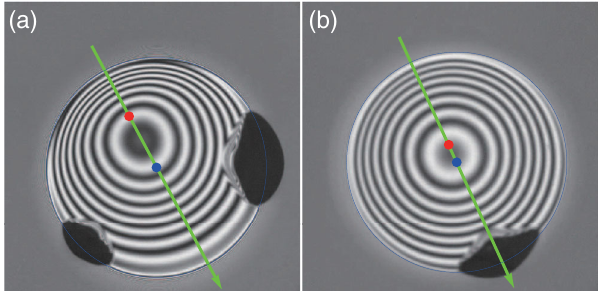
FIG. 19. Bottom view of drop skidding on mica with (a) large and (b) small tilt angles. The droplet center moves from the red to the blue spot along the green arrow line, which is also the axis of